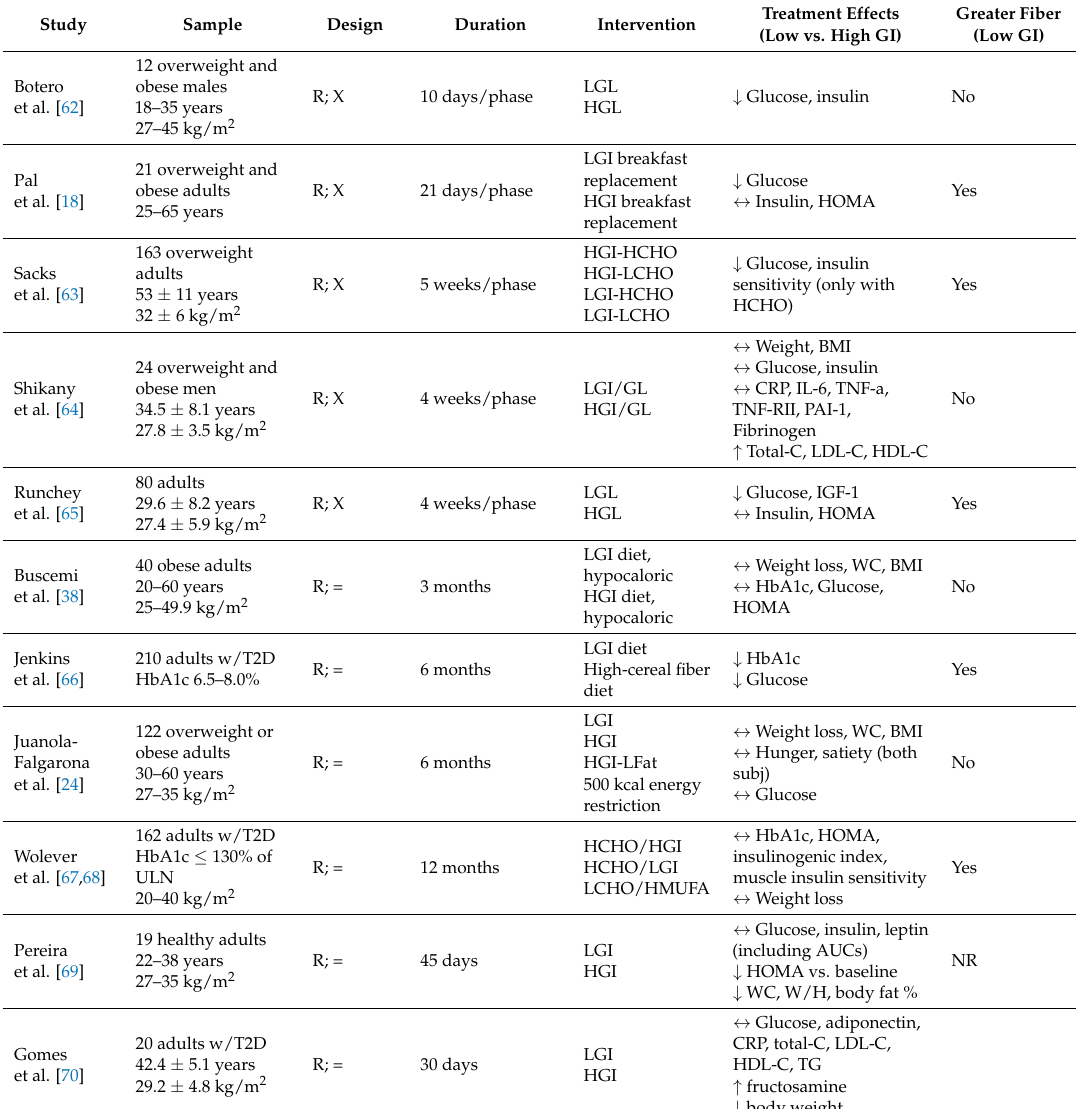
1 Abbreviations: BMI: body mass index; CRP: C-reactive protein; GI: glycemic index; HbA1c: glycosylated hemoglobin; HCHO: high carbohydrate; HDL-C: high density lipoprotein cholesterol; HGI: high GI; HGL: